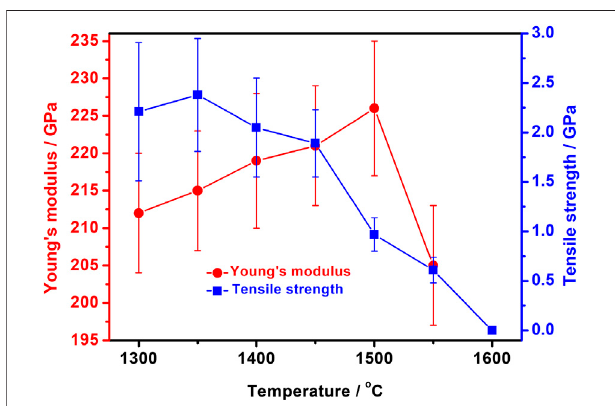
FIGURE 8 | The Young ’ s modulus and tensile strength of SiCN fi bers after annealing at high